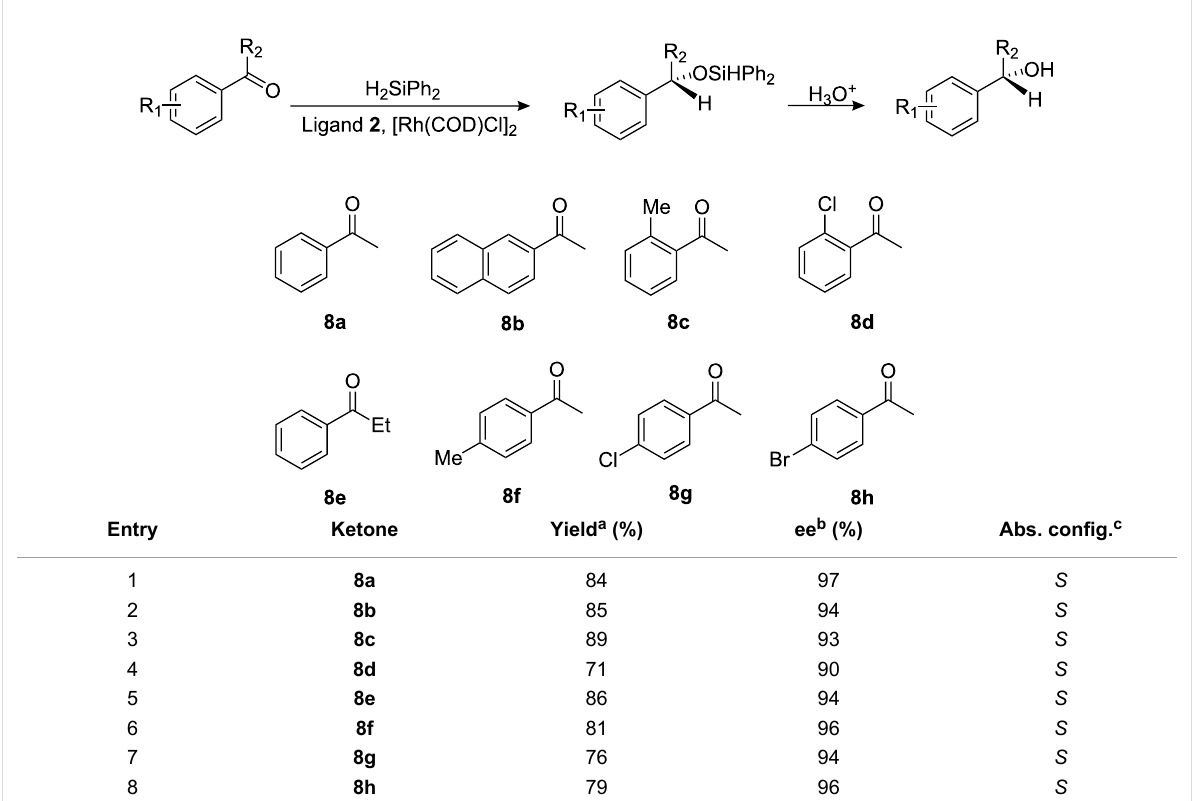
Table 3: Asymmetric hydrosilylation of aromatic ketones catalyzed by ligand 2 and [Rh(COD)Cl] 2 under optimized